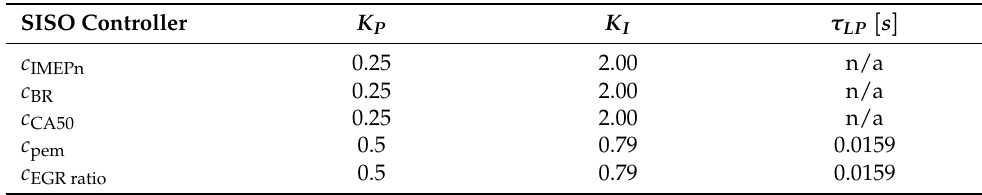
Table 7. Control parameter settings for SISO fuel- and air-path